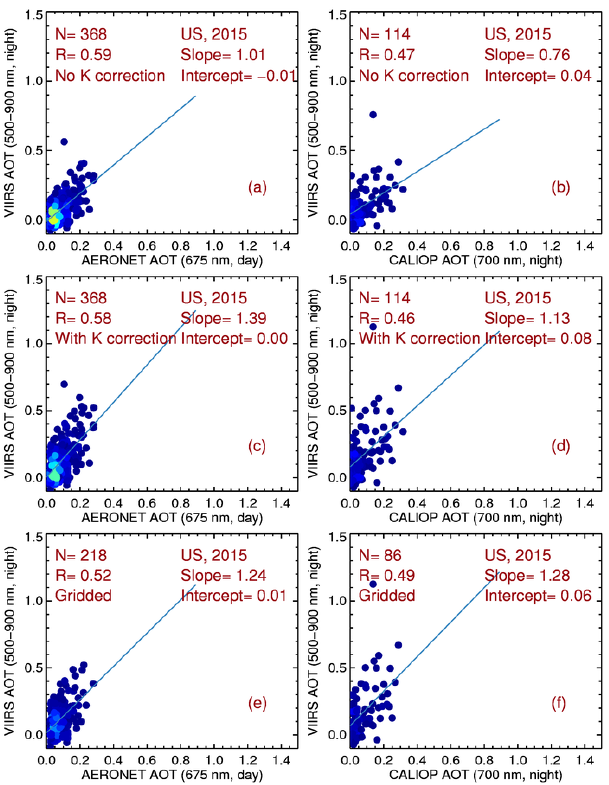
Figure 7. Similar to Fig. 6 but for 999 cities over the Middle East for